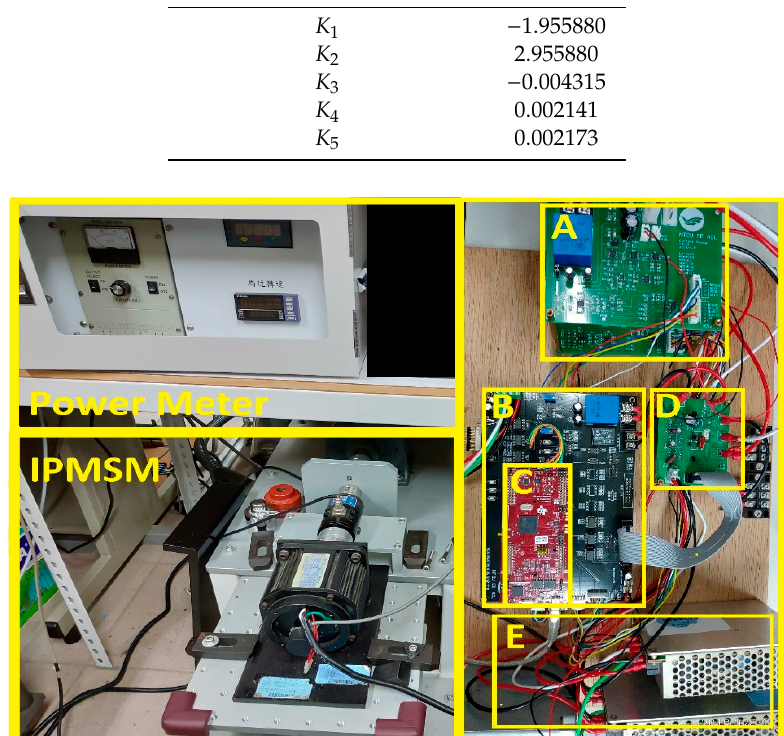
Table 4. Values of composite parameters in Equation (17).